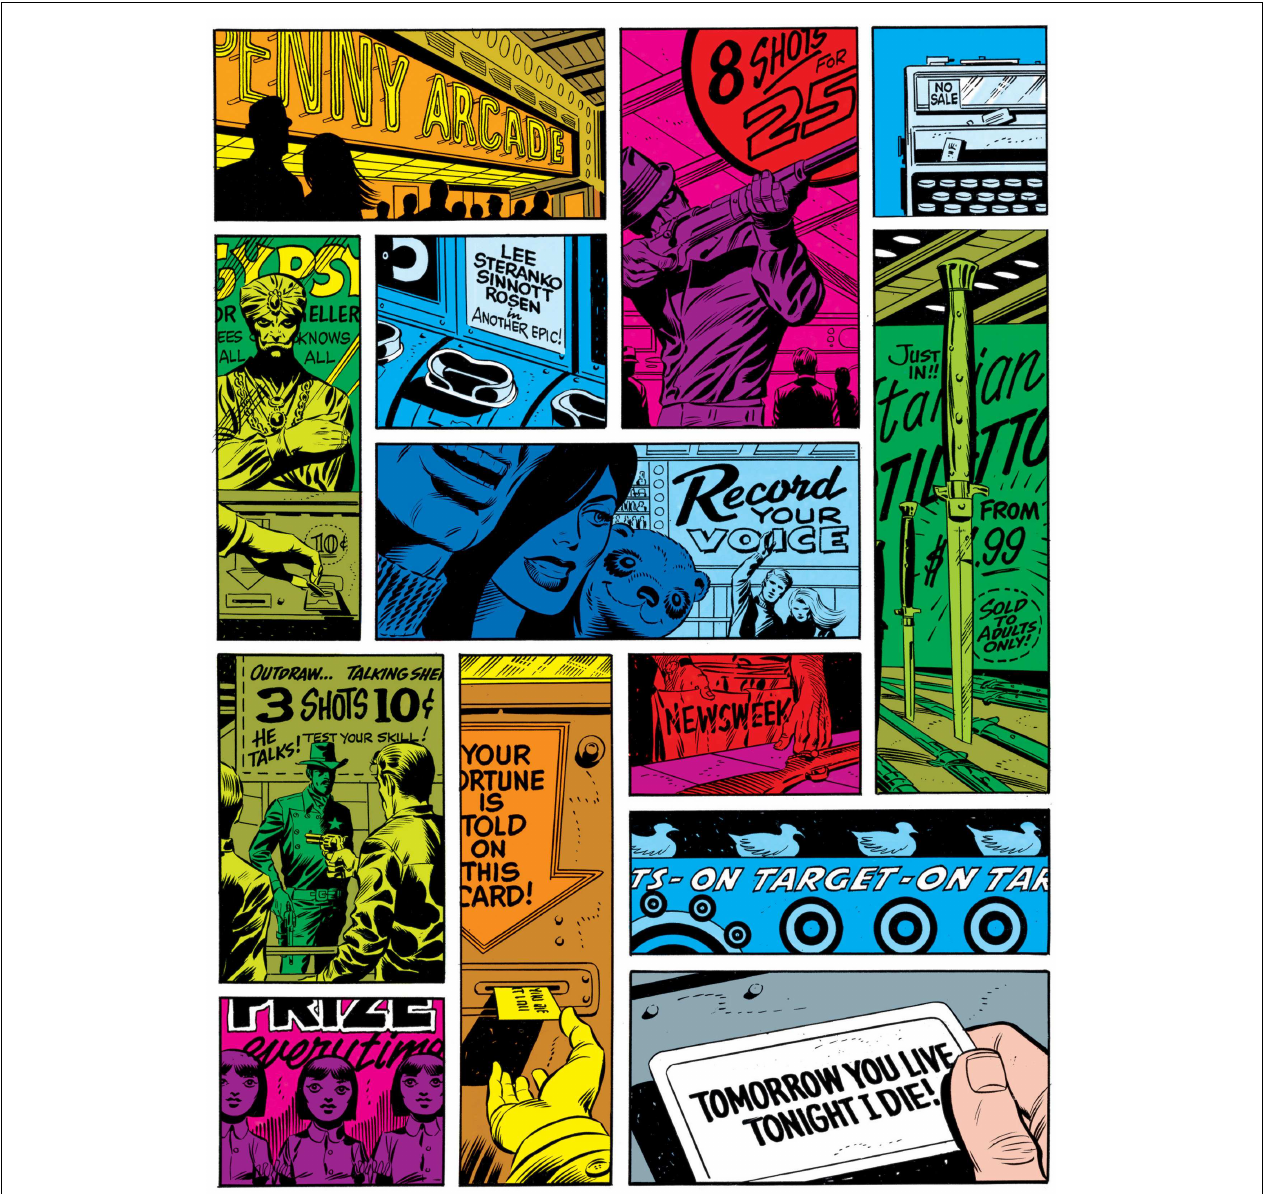
FIGURE 1 | Comic page by Jim Steranko that flouts a conventional linear path of reading (reprinted in Steranko, 2002). Image © 2002 Marvel